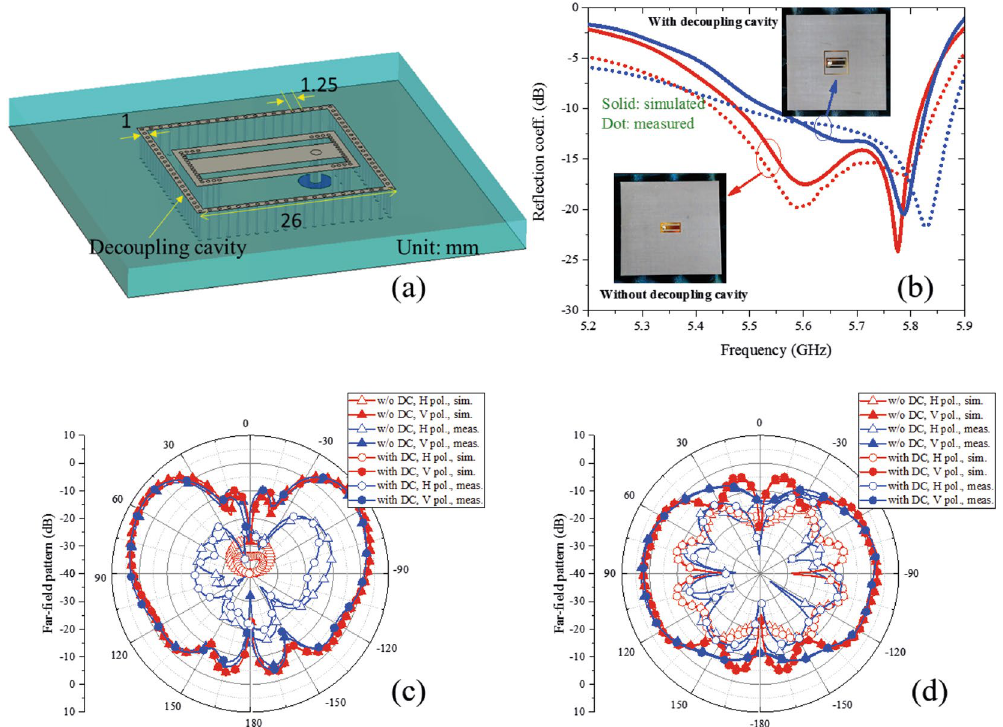
Figure 7. Performances of the dual-mode bidirectional antenna. ( a ) Geometry of bidirectional antenna with a decoupling cavity. ( b ) Simulated and measured reflection coefficients. The embedded figures are photographs of the bidirectional antennas with and without decoupling cavity. Both the two fabricated antennas have a 104 × 104 mm 2 metallic ground. The simulated and measured operational frequency bands with S11 below − 10 dB of the antenna with decoupling cavity are respectively 5.55–5.83 GHz and 5.5–5.88 GHz, which are a little smaller than that of the antenna without decoupling cavity. ( c ) and ( d ) are far-field radiation patterns at 5.8 GHz in the yz plane and xy plane, respectively. The DC, H pol., V pol., sim., and meas. in the figure represent the decoupling cavity, horizontally polarized component, vertically polarized component, simulated, and measured, respectively. The decoupling cavity has little effect on radiation